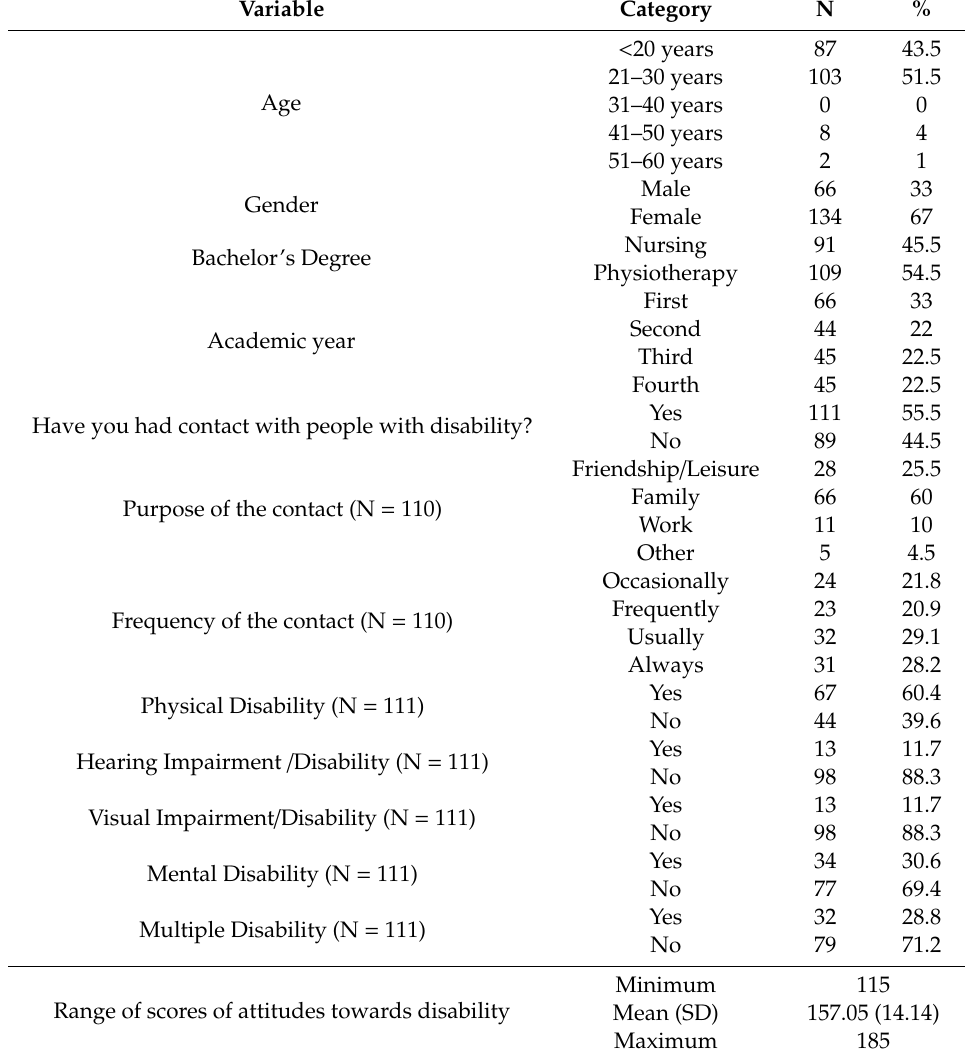
Table 1. Characteristics of the